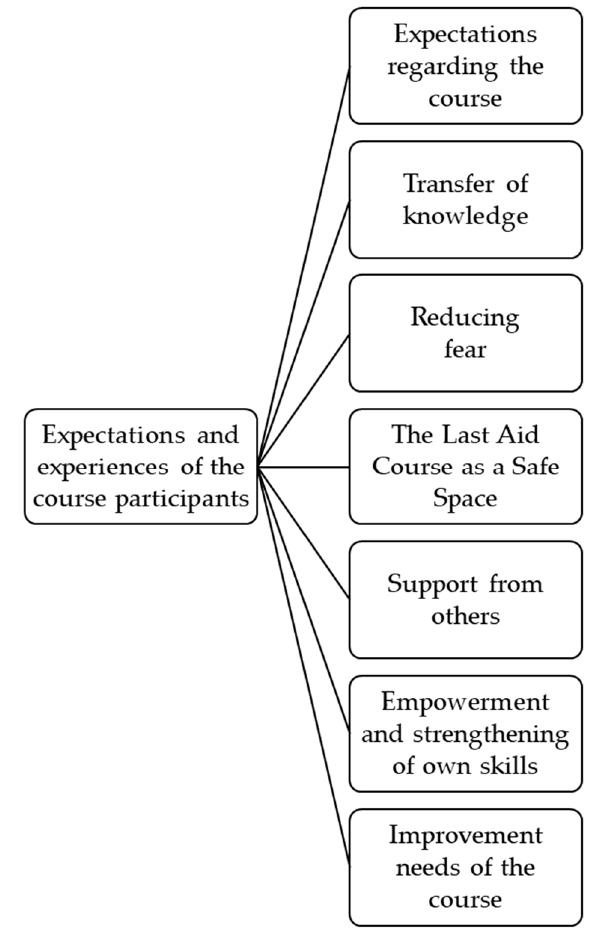
Figure 1. Main topics emerged from the analysis.